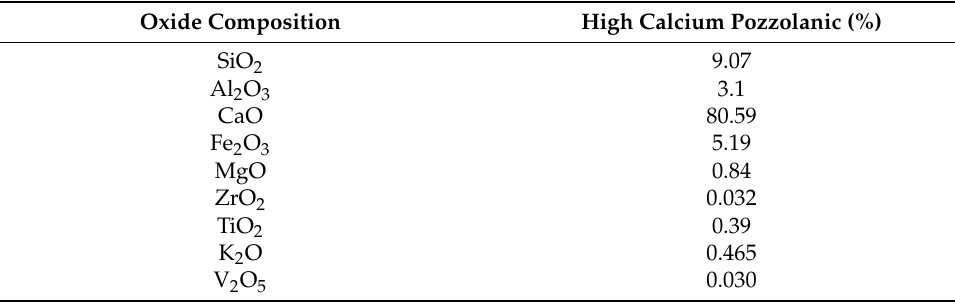
Table 3. Chemical composition of high calcium pozzolanic. Oxide